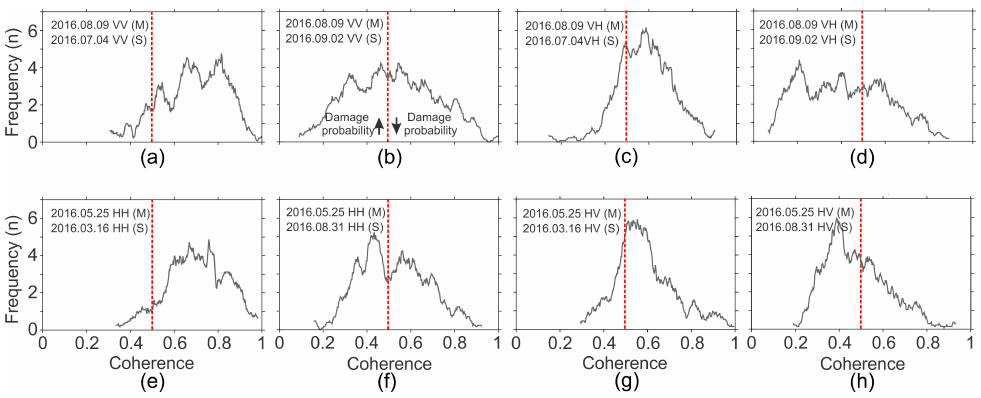
Figure 6. Coherence distribution of Amatrice buildings in different polarizations for Sentinel-1 ( a – d ); and ALOS-2 ( e – h ).